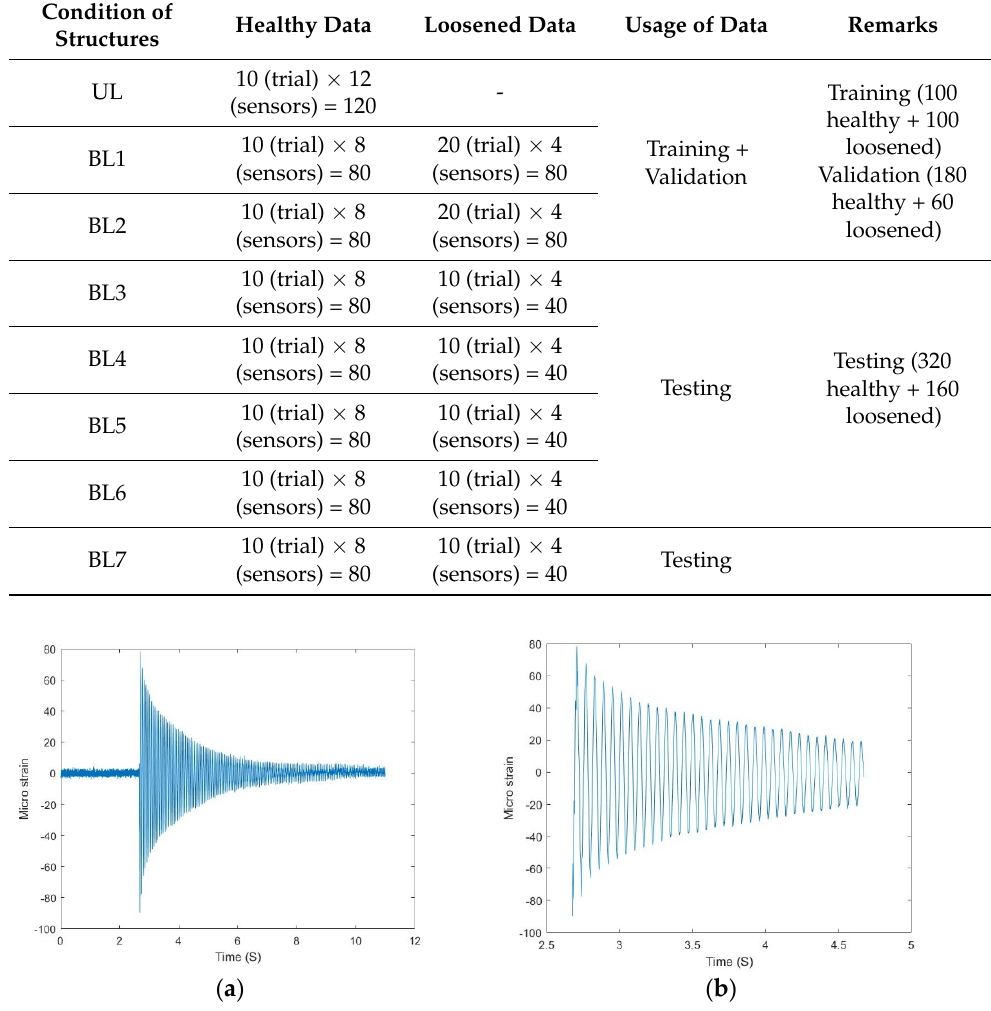
Figure 5. A representative unloosened strain data were collected at SG2: ( a ) entire time history data and ( b ) useful data for the study.